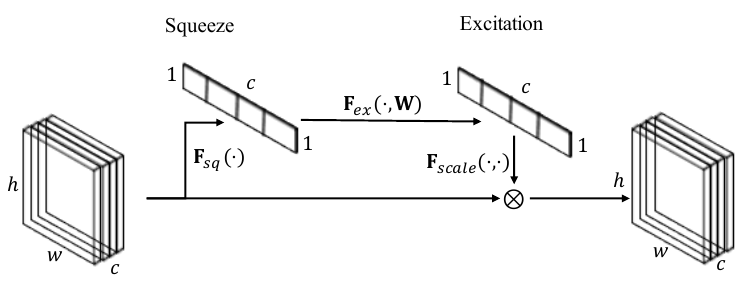
Figure 2. Squeeze-and-Excitation block. The input features are recalibrated ( F scale ( · , · ) ) by learnable weights ( F ex ( · , W ) ) that capture the channel dependencies ( F sq ( · )